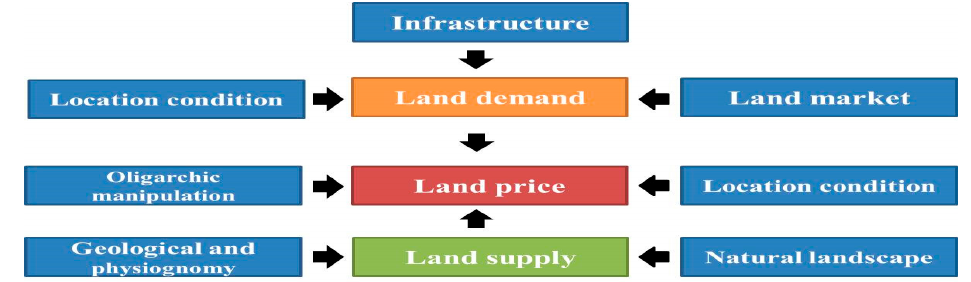
Figure 1. Framework of influencing factors of land price [15].